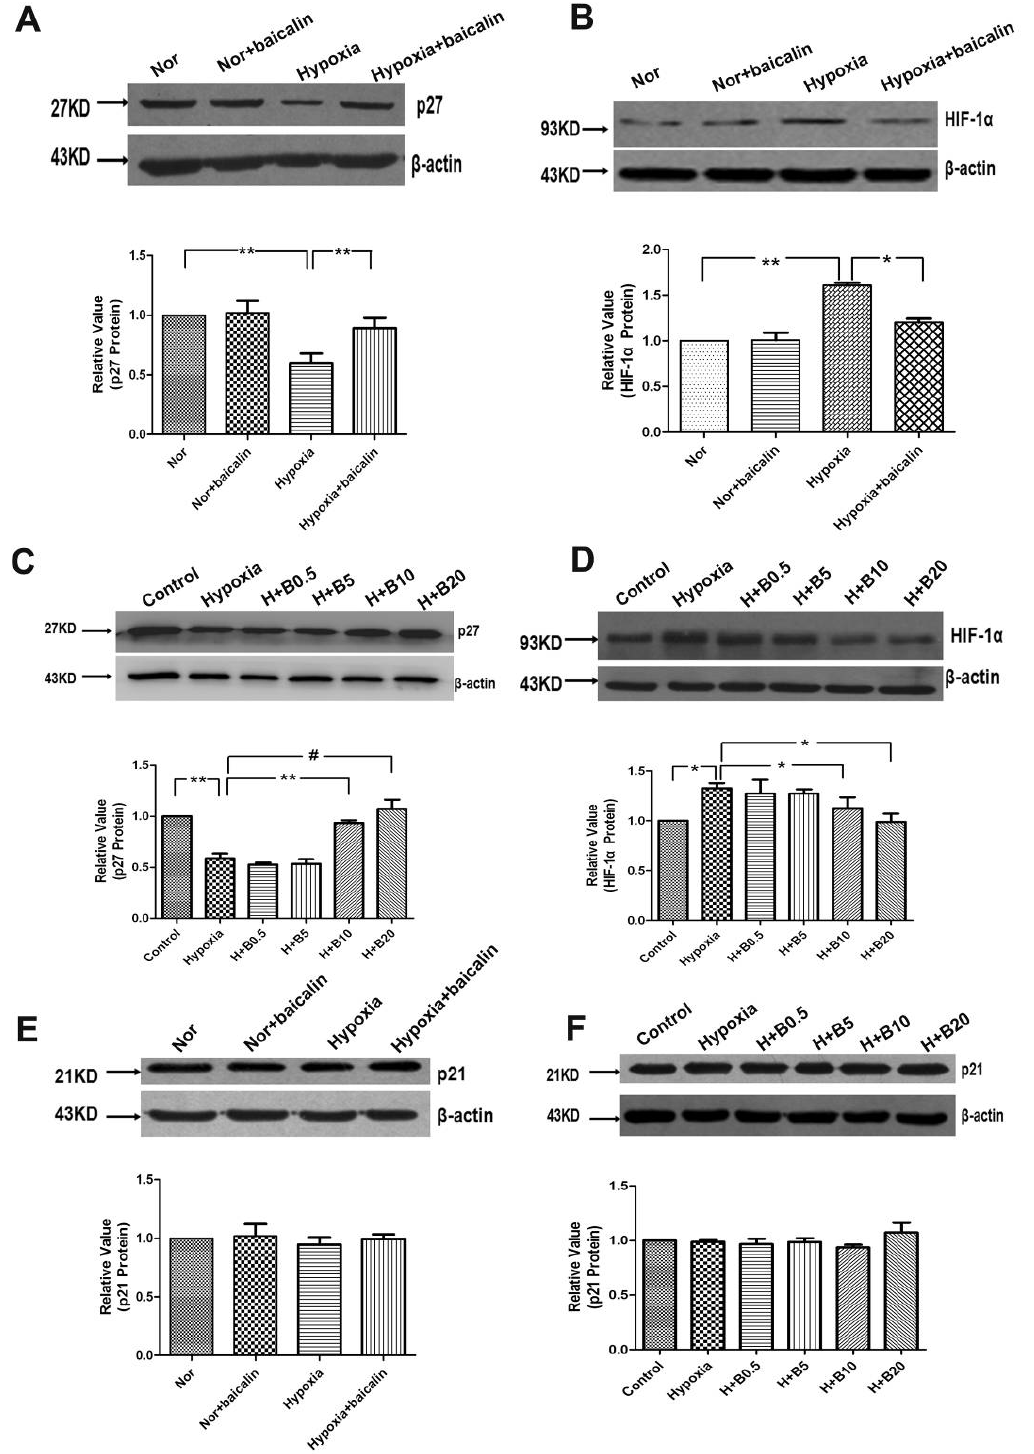
Figure 2. Effects of baicalin on p27 / p21 and HIF-1 α expression in rat lungs and cultured rat PASMCs. ( A , B ) Representative western blotting analysis of p27 and HIF α protein levels in rat lungs; ( C , D ) Representative western blotting analysis of p27 and HIF α protein levels in cultured rat PASMCs; ( E , F ) Western blotting analysis of p21 protein levels in rat lungs and in cultured rat PASMCs. “Nor” means normoxia; “H” means hypoxia; “B” means baicalin. ( # p < 0.001; ** p < 0.01; * p < 0.05). All values are denoted as the mean ± SEM from at least three separate